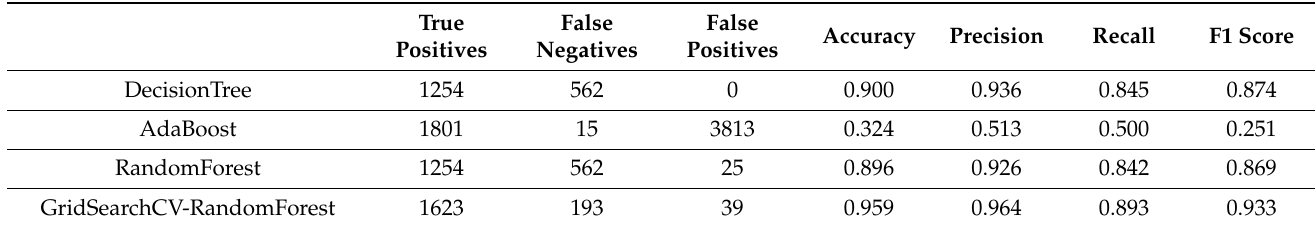
Table 12. Real dataset detection